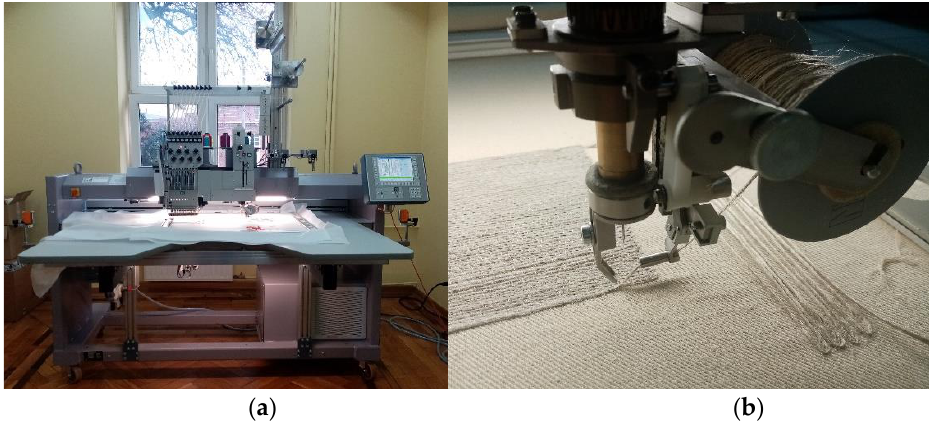
Figure 1. ( a ): ZSK computer embroidery machine; ( b ): W-type head for technical embroidery (own source).